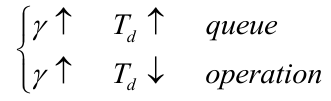
Fig. 5. Changes in multiple parameters (resources) for a single output variable